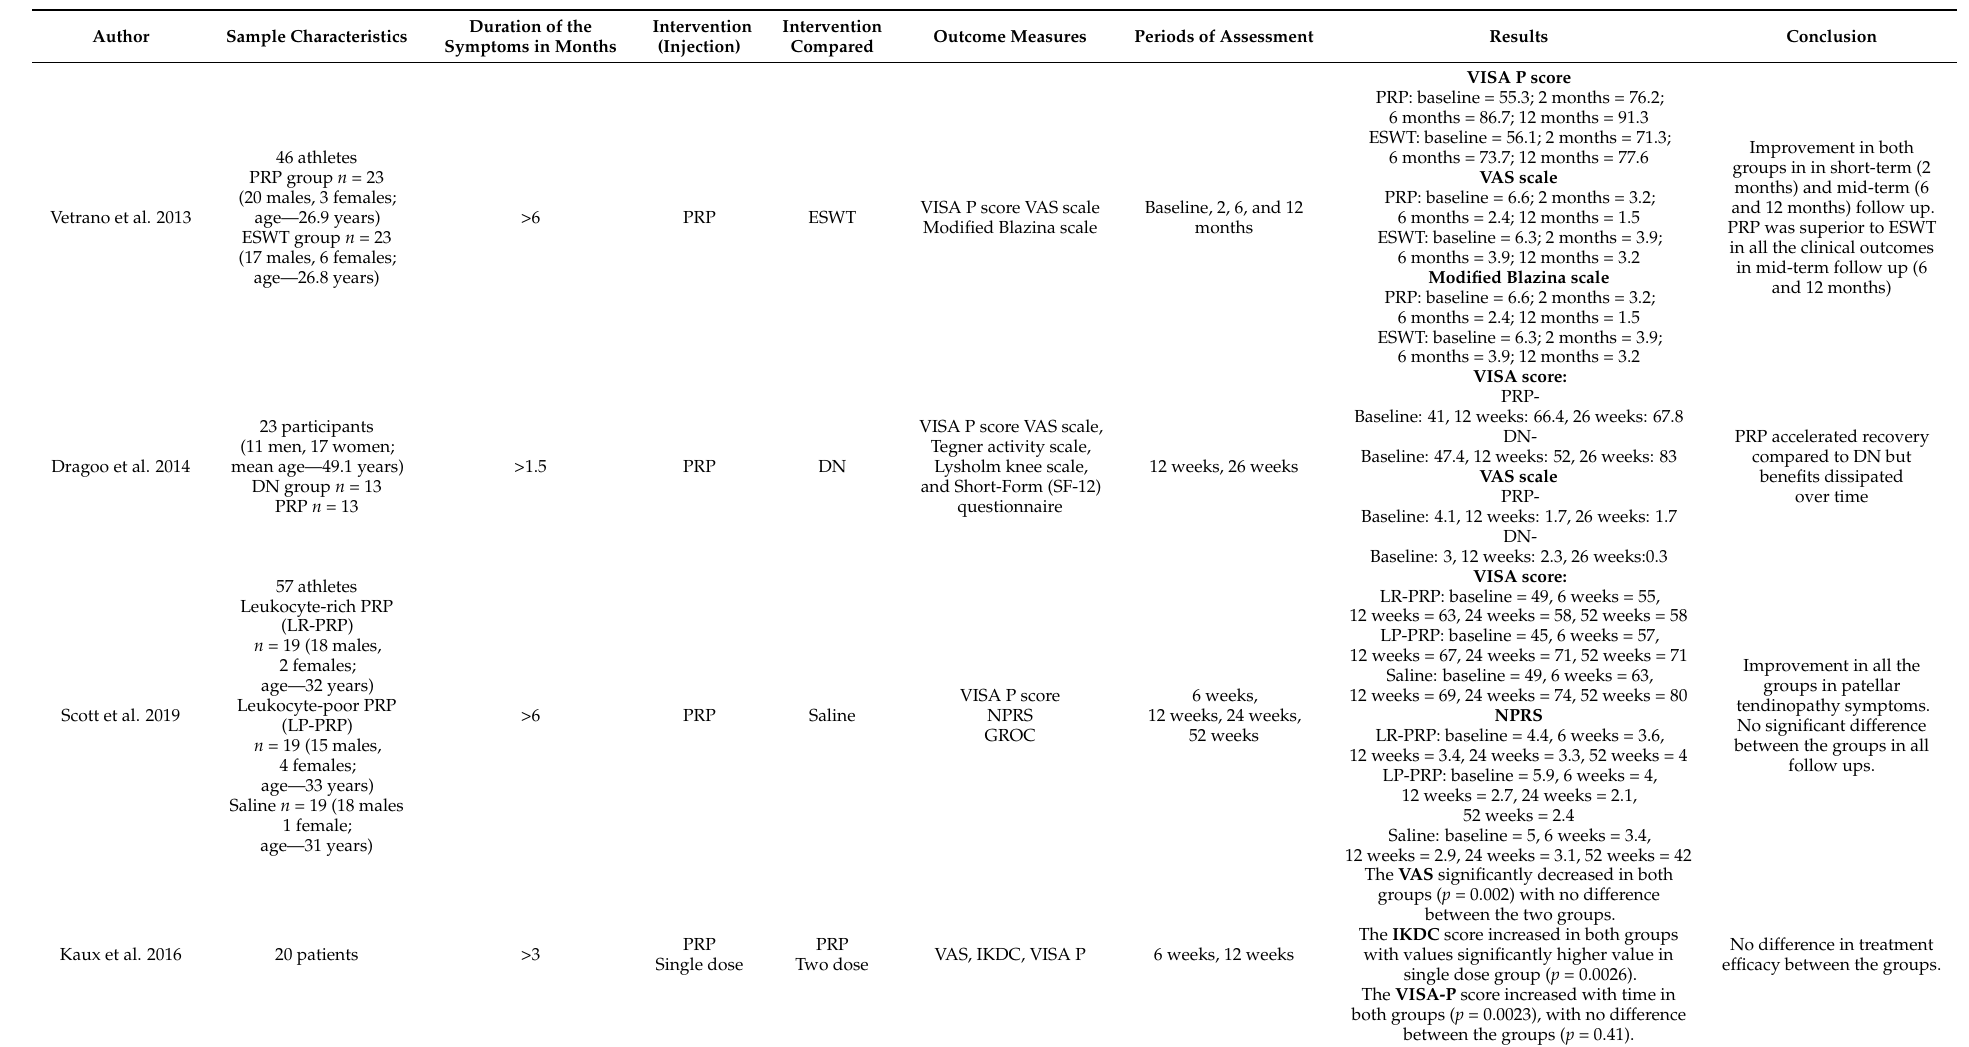
Table 1. Characteristics of the included